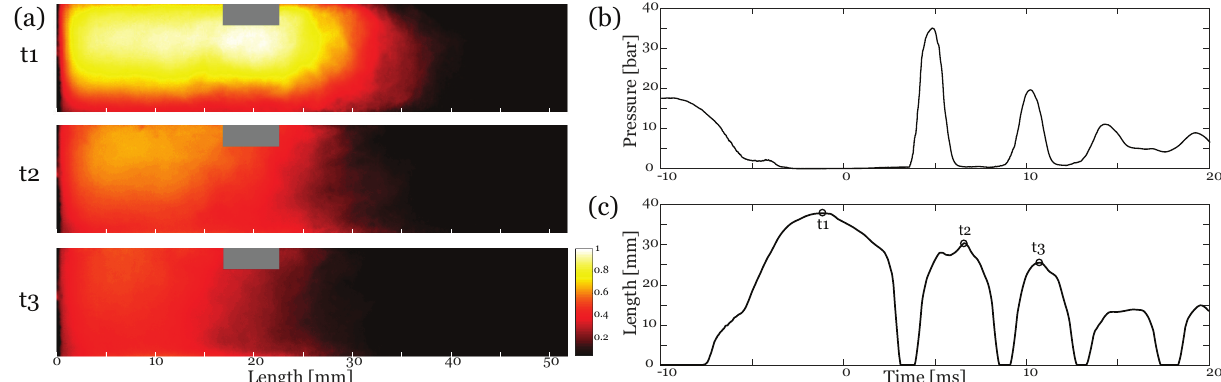
Figure 7. Column separation length for Re = 2239. ( a ) Ensemble-averaged vapor distribution for N = 9 tests at different snapshots (see t1–t3 in ( c )). Vapor intensity range [ 0.05,1 ] . For camera settings, see Table 2 (high). The region of P1 pressure sensor (grey) has been omitted from the data. ( b ) Ensemble-averaged pressure at P1 pressure sensor. ( c ) Column separation length at 1st to 3rd peak length after valve